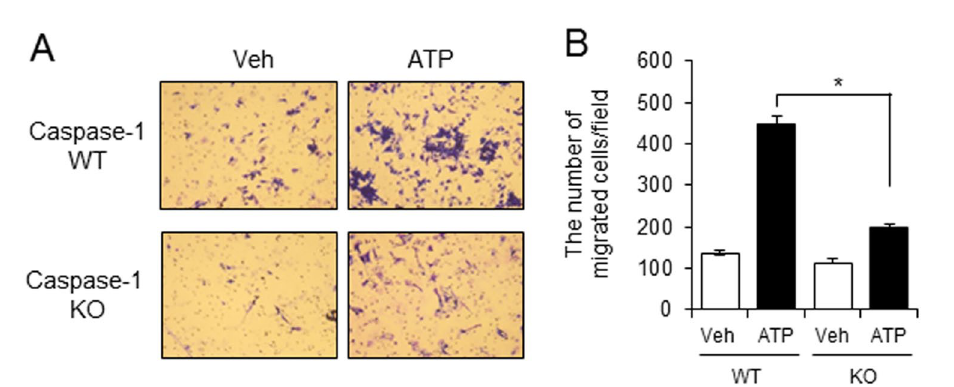
Figure 3. Caspase-1-deficient macrophages have greatly reduced capacity to stimulate migration of melanoma cancer cells. Primary mouse macrophages derived from wild-type (WT) or caspase-1 knockout (KO) mice were primed with LPS (100 ng/ml) for 4 hr. The cells were stimulated with ATP (5 mM) for 1 hr. Conditioned culture supernatants were collected and added to the bottom chambers of transwells which had B16F10 cells plated in the upper chamber. After 24 hr, cell migration was determined. ( A ) Images of B16F10 cell migration. ( B ) The number of migrating B16F10 cells was counted in the microscopic field. Values are means ± SEM (n = 3). * p <